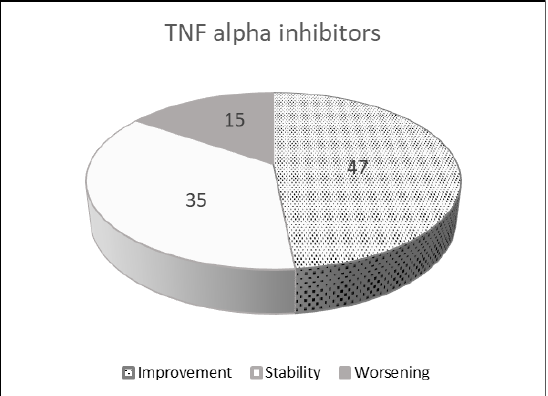
Figure 1. Pulmonary effects of TNFi in RA-ILD patients: a review of the literature.